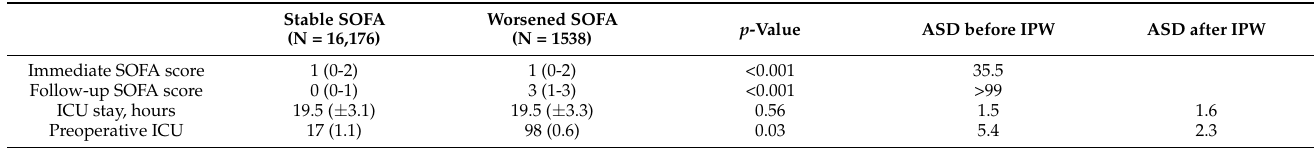
Table 2. Baseline characteristics according to SOFA score change during short ICU